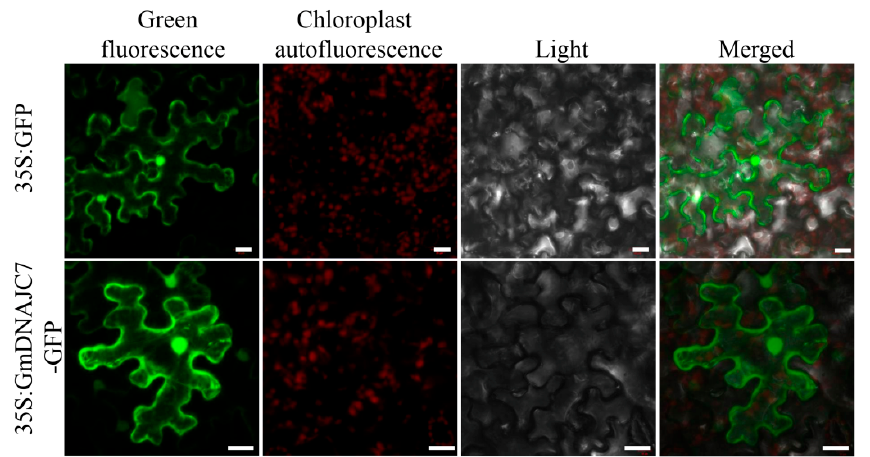
Figure 4. Subcellular localization of the GmDNAJC7–GFP fusion protein in the leaf cells of Nicotiana benthamiana . Bars, 10 μ m.